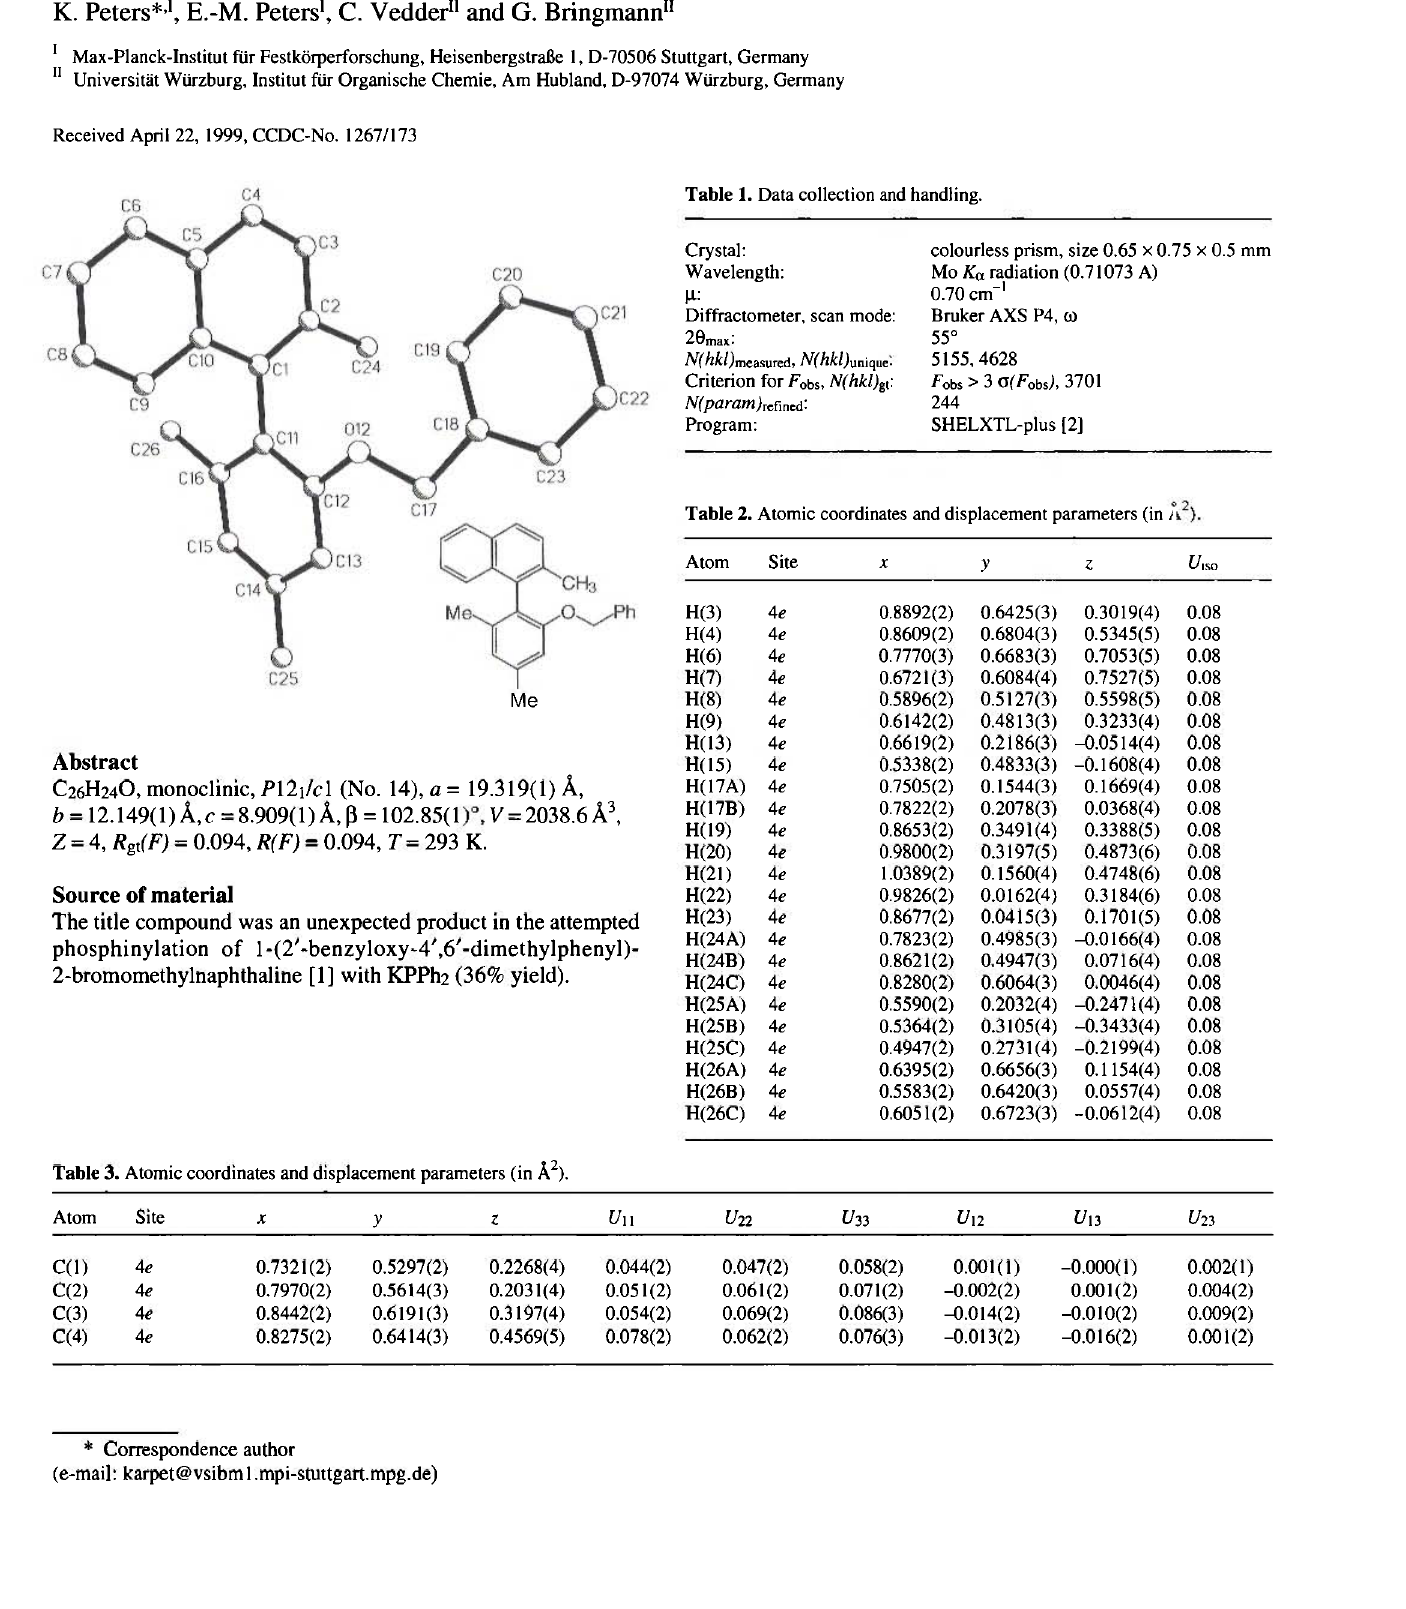
Table 3. Atomic coordinates and displacement parameters (in A 2